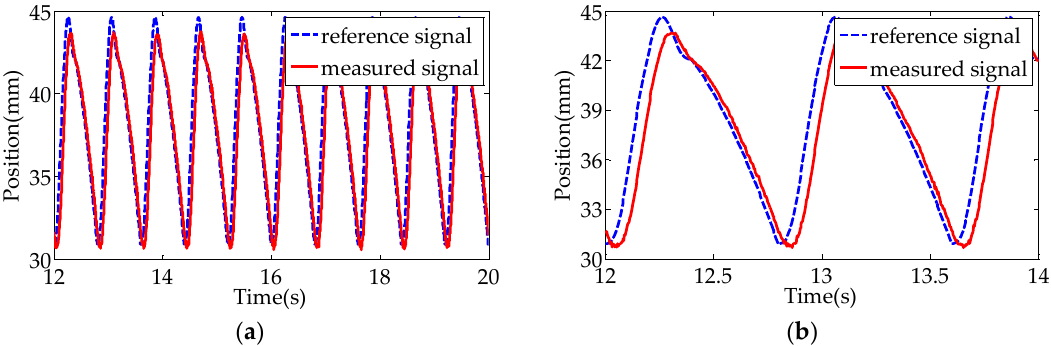
Figure 14. The pitching hip joint position tracking curves of the RF leg of the robot. ( a ) Response curves; ( b ) Local amplification curves.